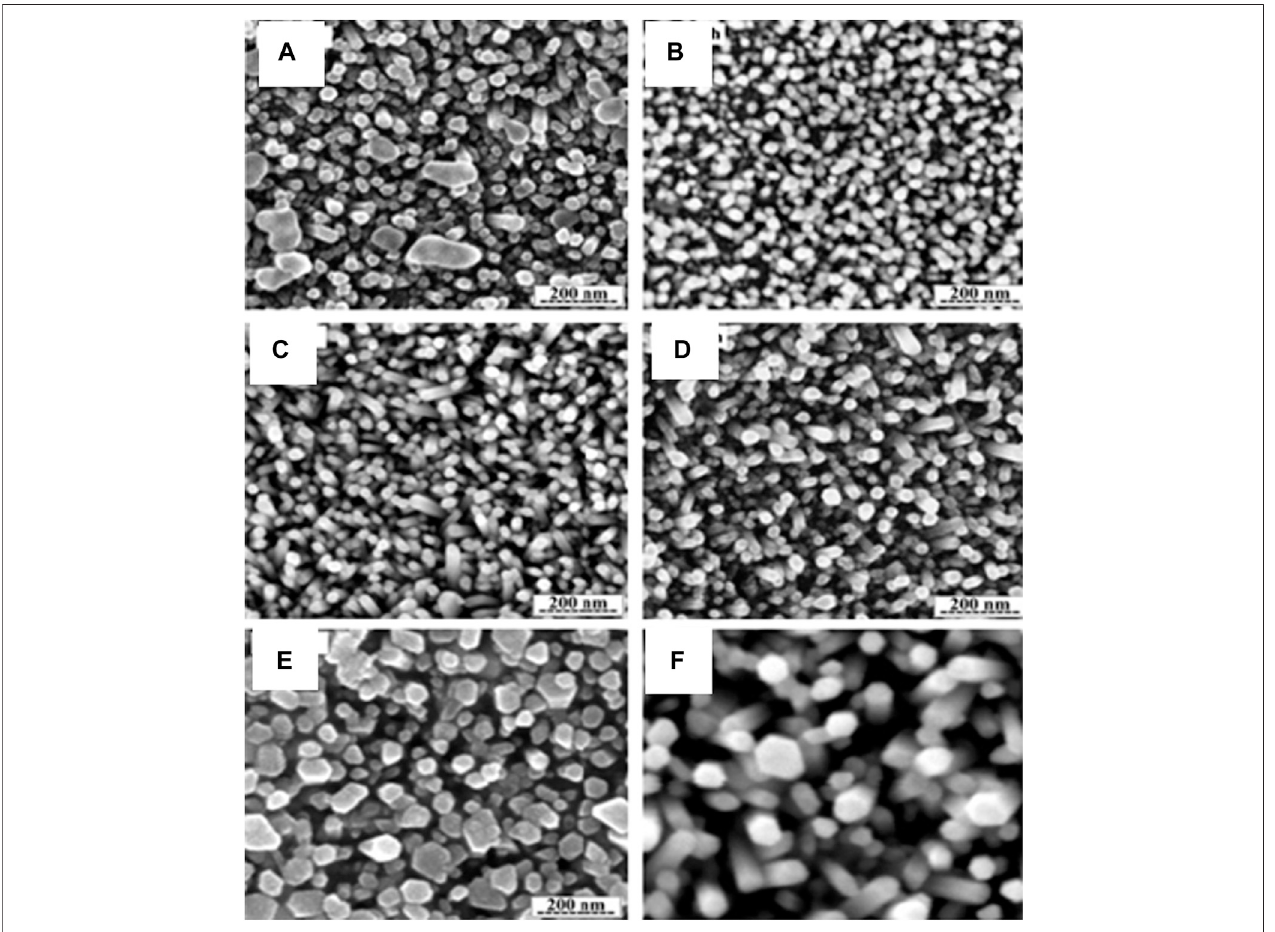
FIGURE 8 | FESEM images of the ZnO nanorods with 0.050 M for different growth time: (A) 2, (B) 3.5, (C) 5, (D) 6.5, (E) 8 h and (F) show the hexagonal shape of ZnO nanorods (Shabannia, 2016).